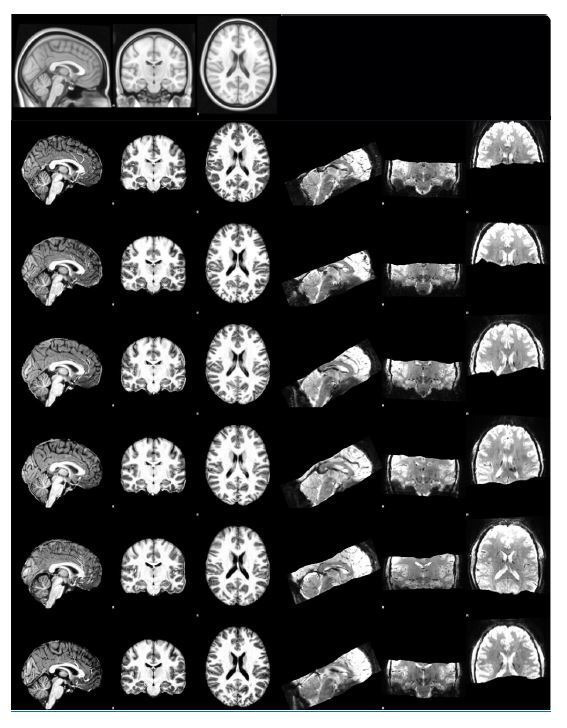
Mid-sagittal, coronal and axial slices in the MNI-space for every T1-weighted (first 3 columns) and fMRI-dataset (last 3 columns).Every row represents a participant. The first row shows the relevant MNI slices. Also see Author responses image 2-4.